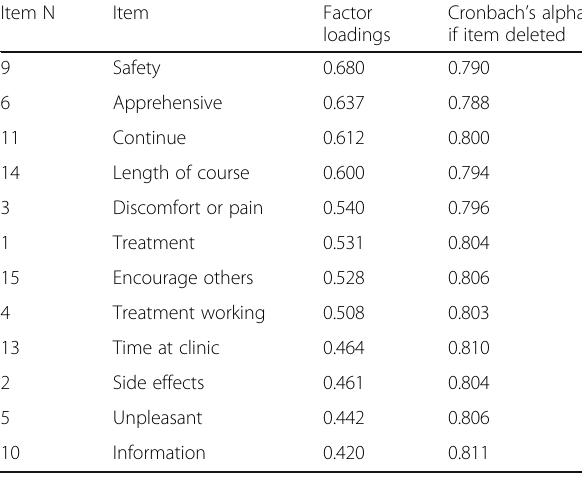
Table 5 MacTSQ Single scale forced one factor: Principal axis factoring factor loadings and internal consistency